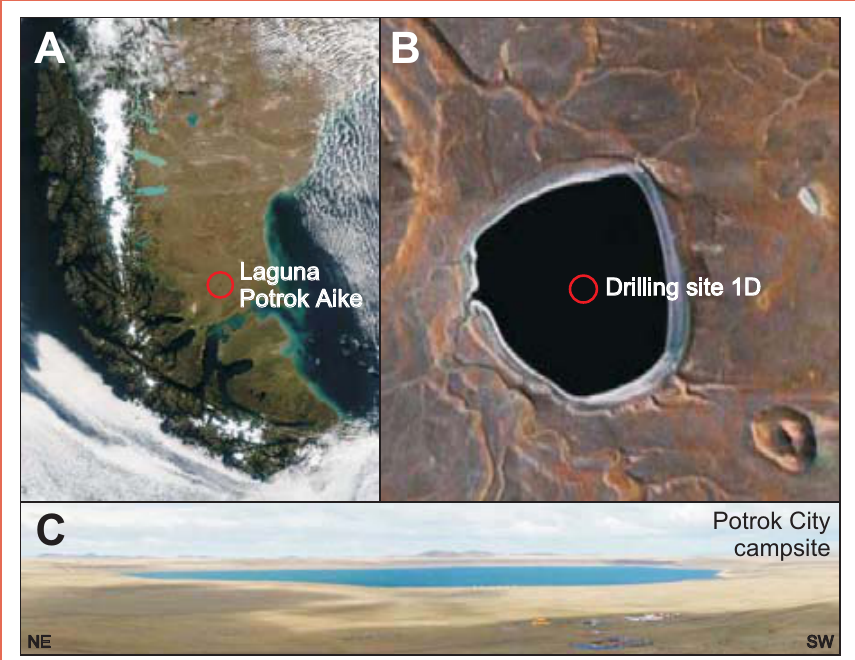
Figure 1. [A] Satellite image of Laguna Potrok Aike located in southernmost continental Patagonia, north of the Strait of Magellan, from http://www.zonu.com; [B] close-up of the lake showing the position of the drilling site discussed here, from http://earth.google.com; [C] panoramic view of the lake site with the field camp in the foreground.